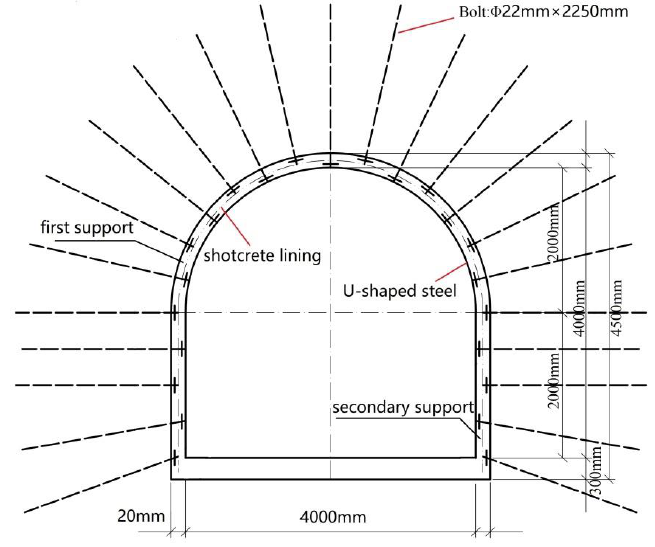
Figure 3. Primary support method used in the test roadway.